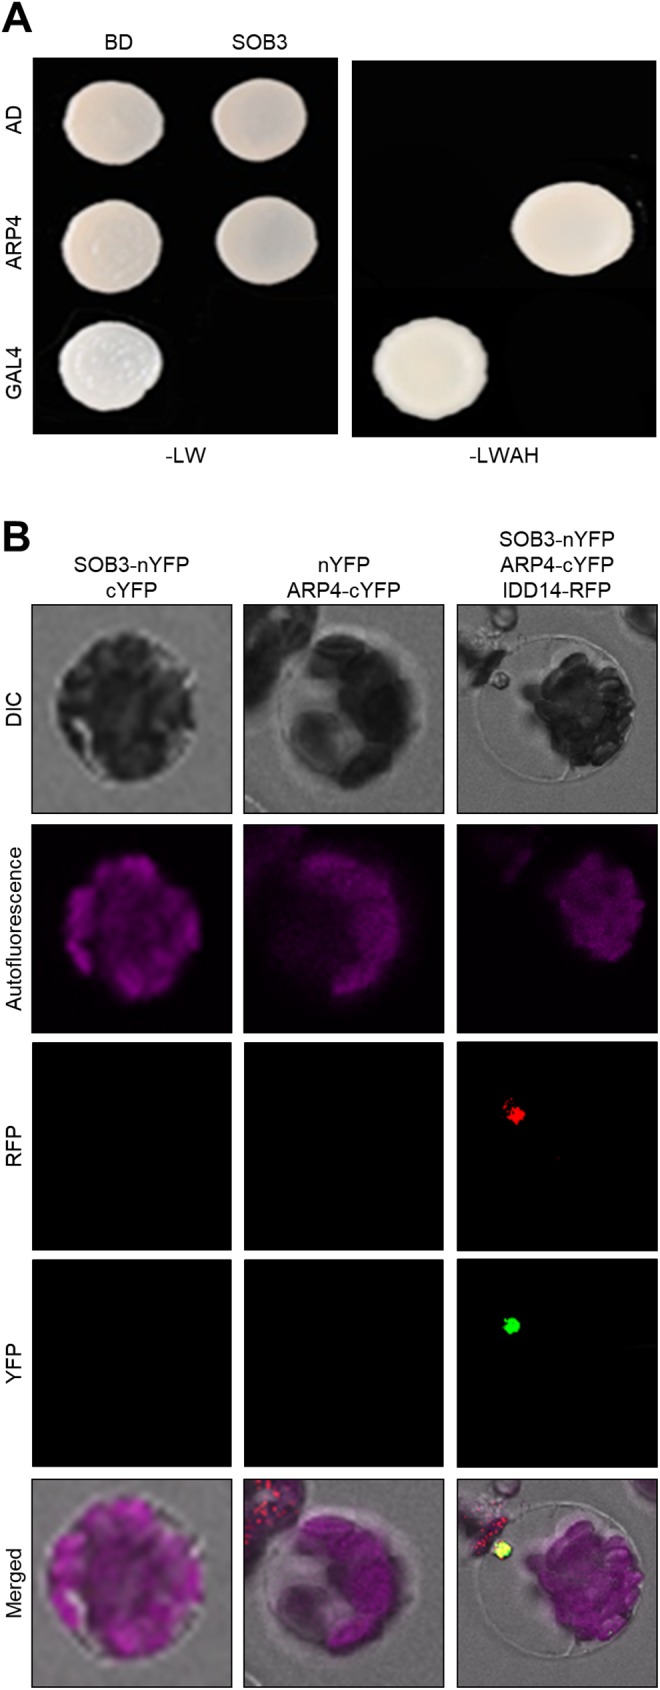
Interaction of SOB3 with the SWR1 component.(A) Y2H analysis. Y2H assays were performed with the SOB3 protein fused to the DNA-binding domain (BD) of GAL4 and ARP4 fused with the transcriptional activation domain (AD) of GAL4 for analysis of interactions. Interactions were examined by cell growth on selective media. -LWHA indicates Leu, Trp, His, and Ade drop-out plates. -LW indicates Leu and Trp drop-out plates. GAL4 was used as a positive control. (B) BiFC assays. Partial fragments of YFP protein were fused with SOB3 and ARP4. IDD14-RFP was used as a nuclear marker.